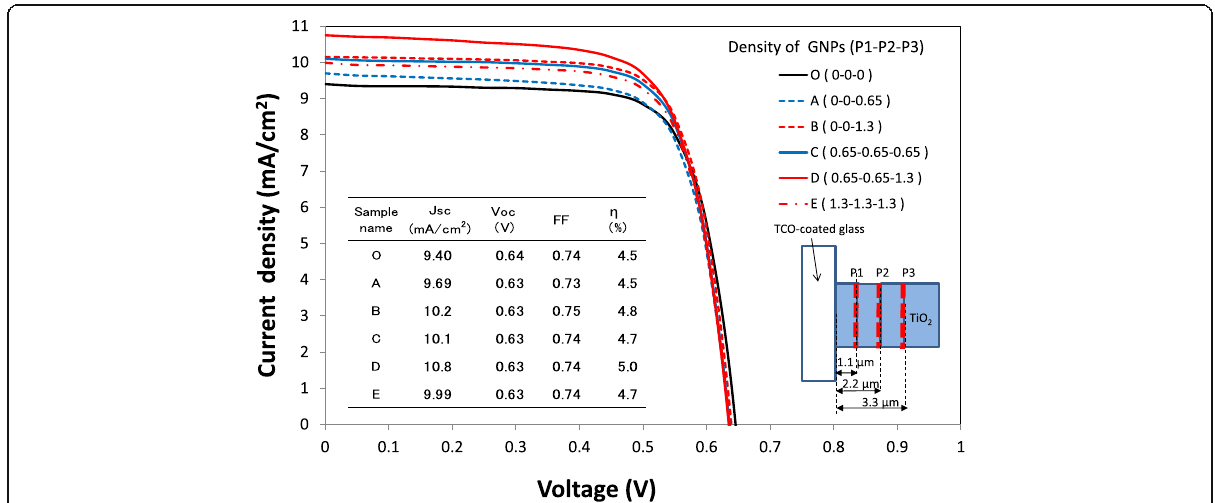
Fig. 14 Current density – voltage curves of the DSSCs with varying the number of GNP layers and the density of GNP layers. The GNP layers of P1, P2, and P3 were formed at positions of 1.1, 2.2, and 3.3 μ m from the TCO surface, respectively. The numbering in the legend with the format (P1- P2-P3) shows the density of GNPs ( μ g/cm 2 ) at each